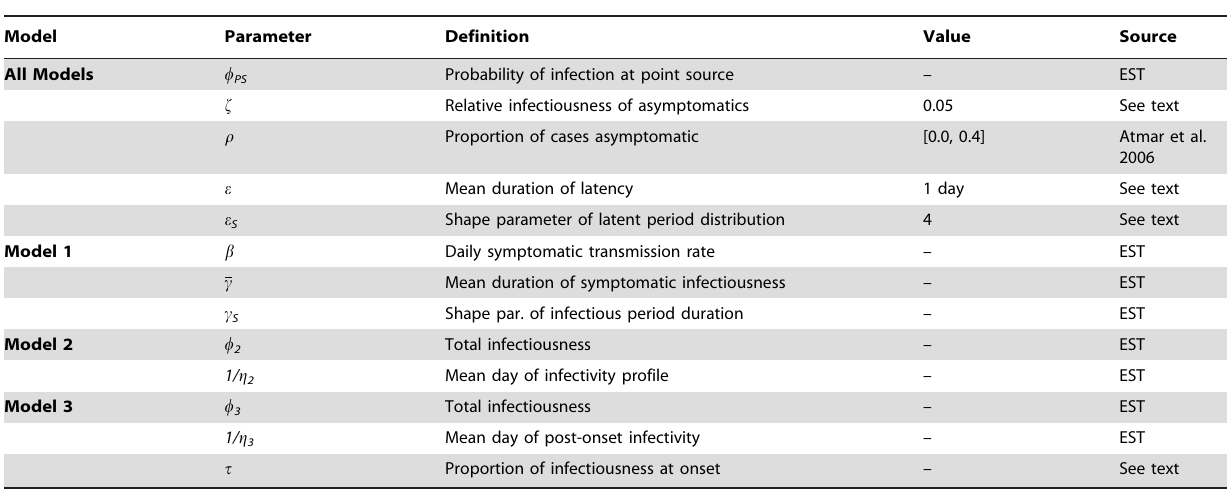
Table 1 . Parameters and